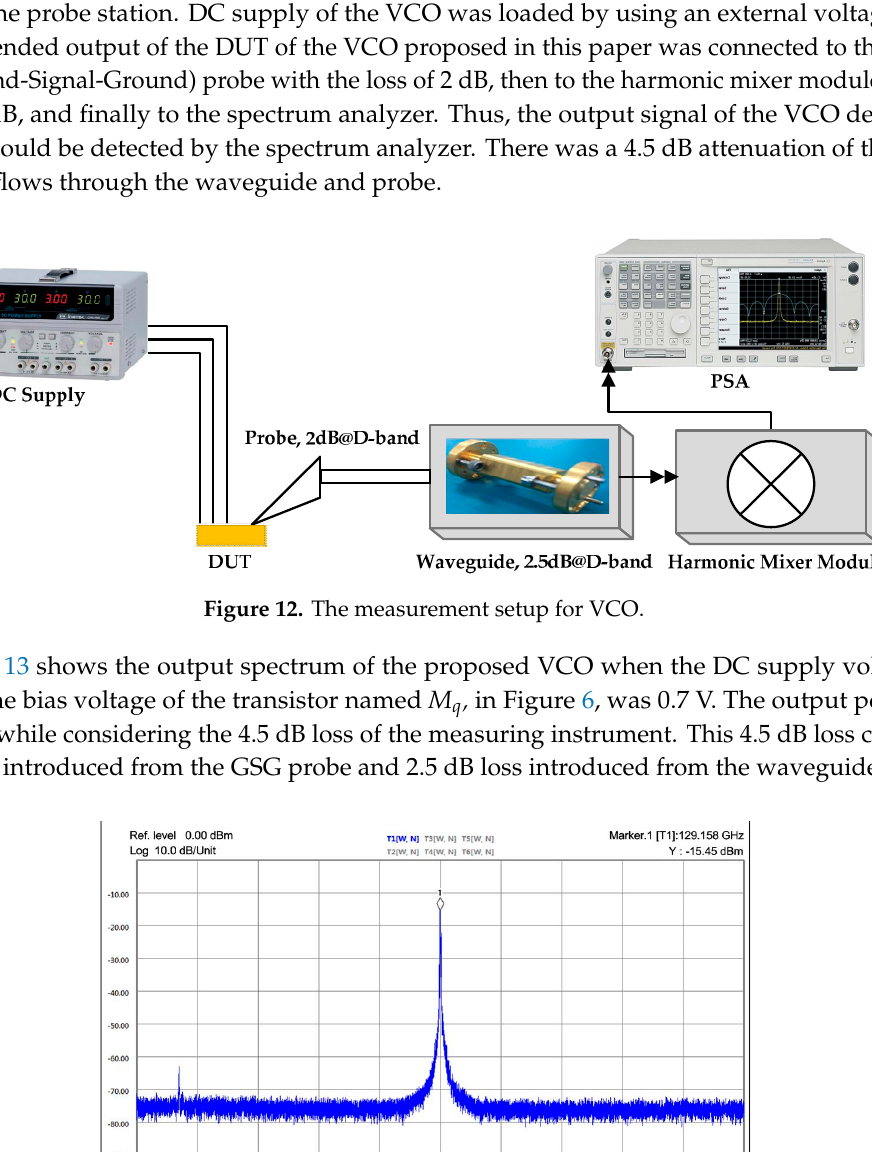
Figure 13. The spectrum of the proposed VCO.